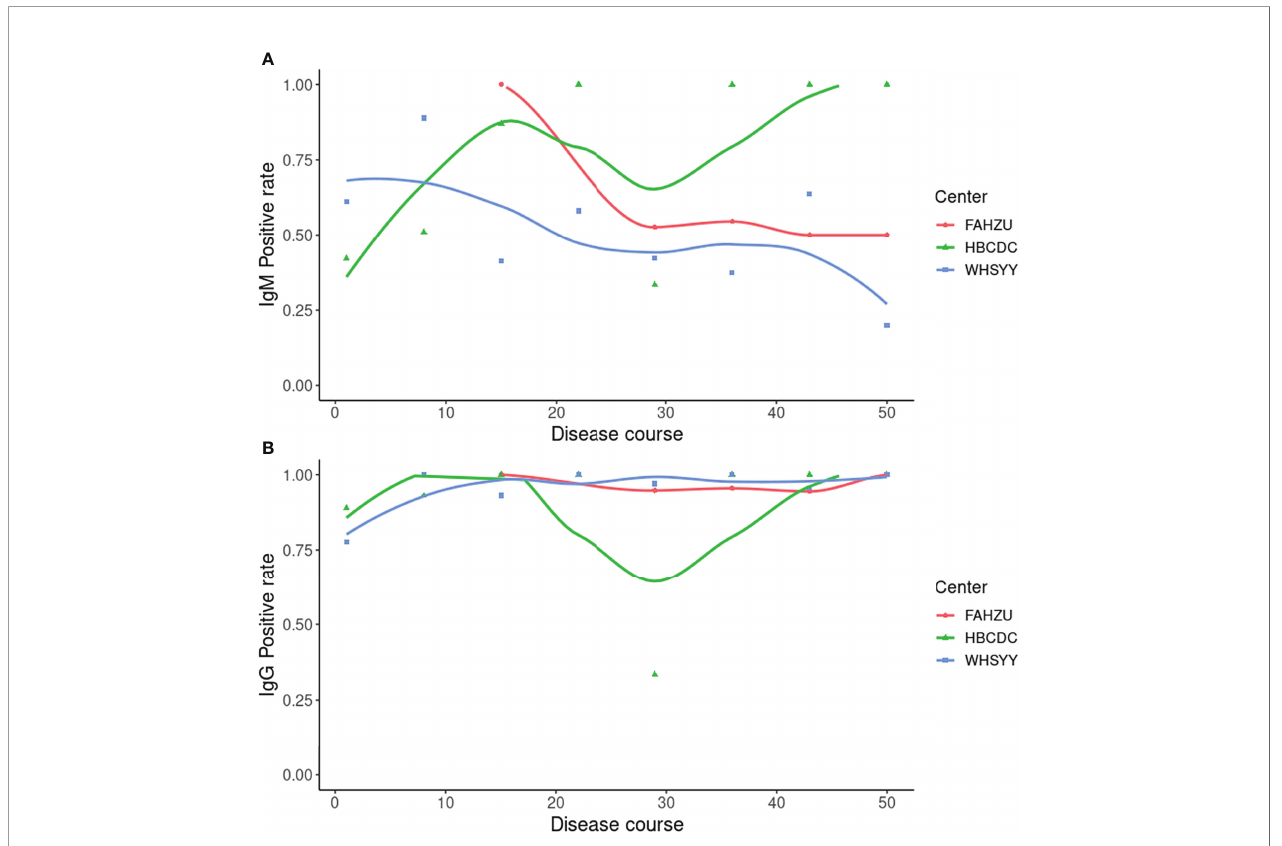
FIGURE 2 | Positive rate of IgM and IgG by ALLtest. (A) Positive rate of IgM along the disease course; (B) Positive rate of IgG along the disease course. Curves were drawn by local polynomial regression fi tting.